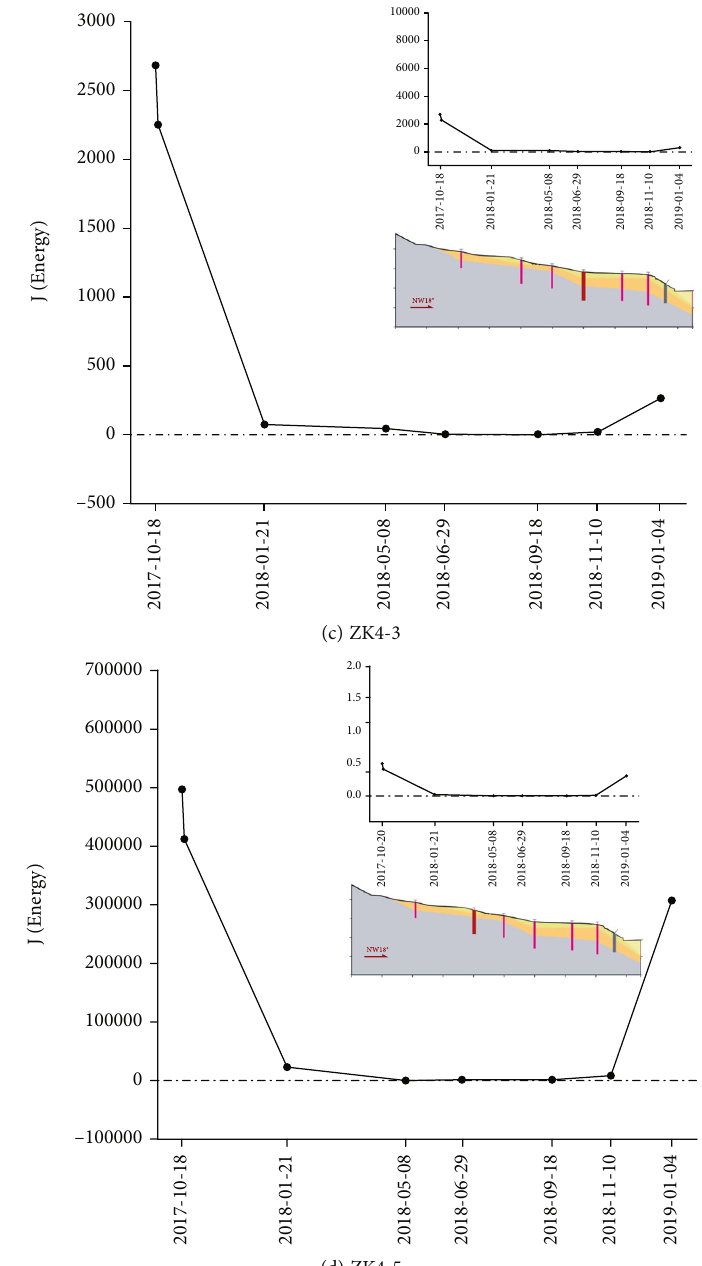
Figure 17: Kinetic energy of ZK4-1, ZK4-2, ZK4-3, and ZK4-5